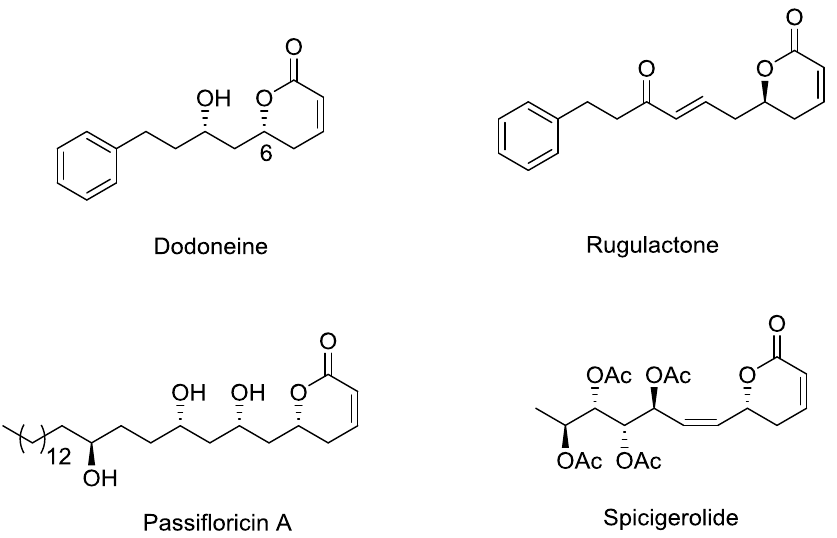
Figure 1. Structures of natural pyranone having long side chains.